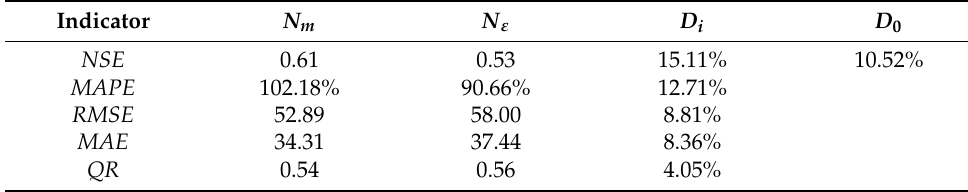
Table 5. Model stability analysis